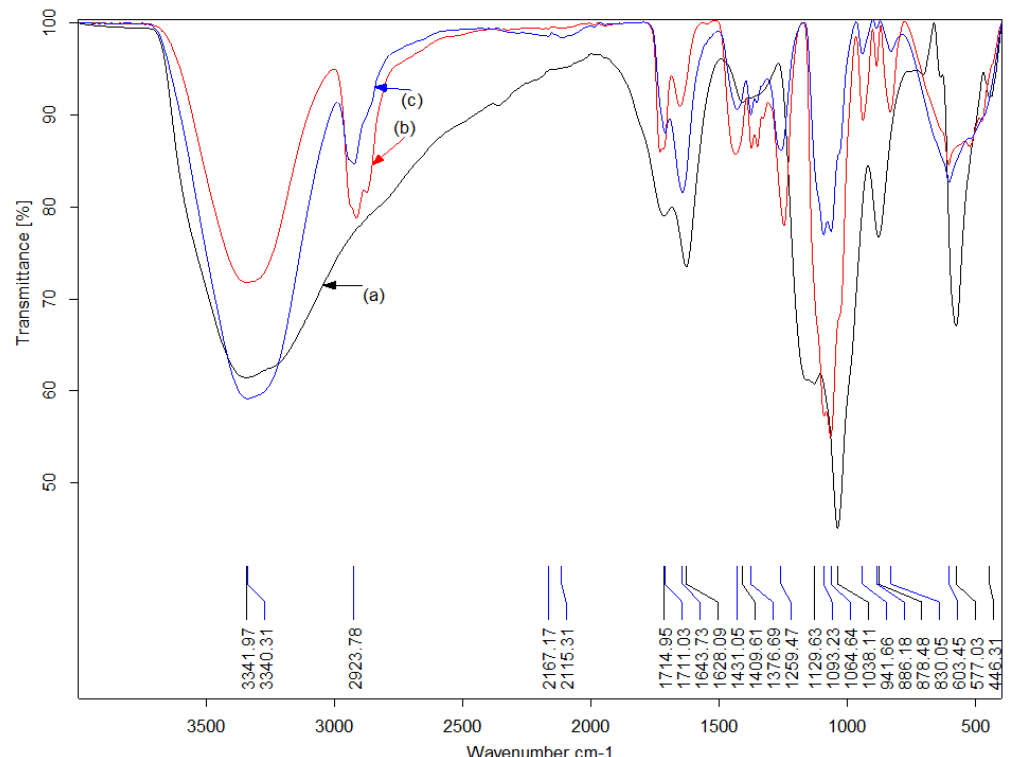
Fig. 3: FTIR Spectrum of (a) Graphene Oxide, (b) GO-PEG-PVA hydrogel and (C) PVA-PEG Fig.3